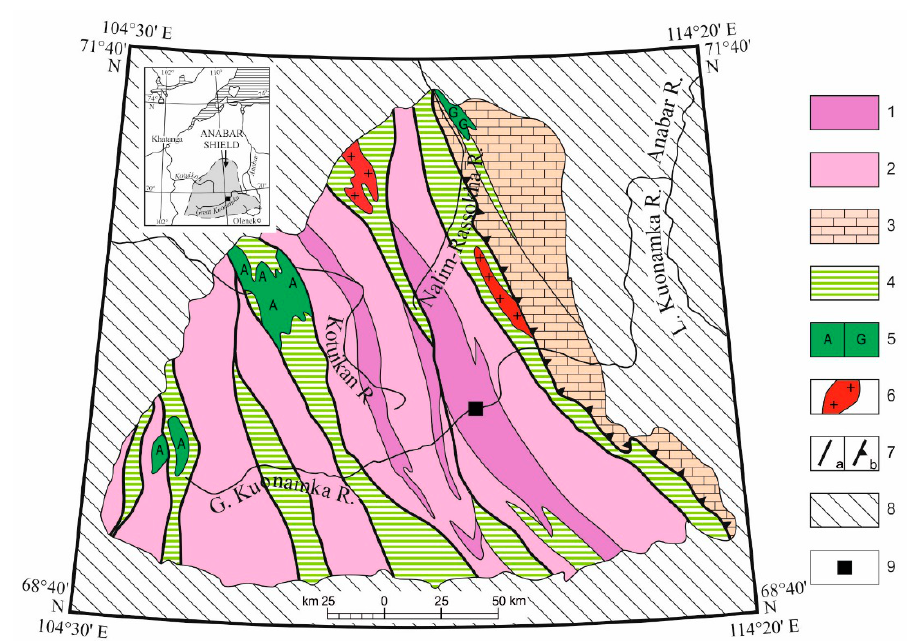
Figure 2. Schematic geological map of the Anabar Shield. (1–3) Archean and Early Proterozoic metamorphic rocks: (1) Daldyn Group; (2) Upper Anabar Group; (3) Khapchan Group; (4) Early Proterozoic shear zones. (5) Intrusive rocks: (A) anorthosite and (G) gabbroids. (6) autochthonous and parautochthonous granitoids. (7) Major faults: (a) steep faults and (b) overthrusts. (8) platform cover; (9) area of Figure 2.